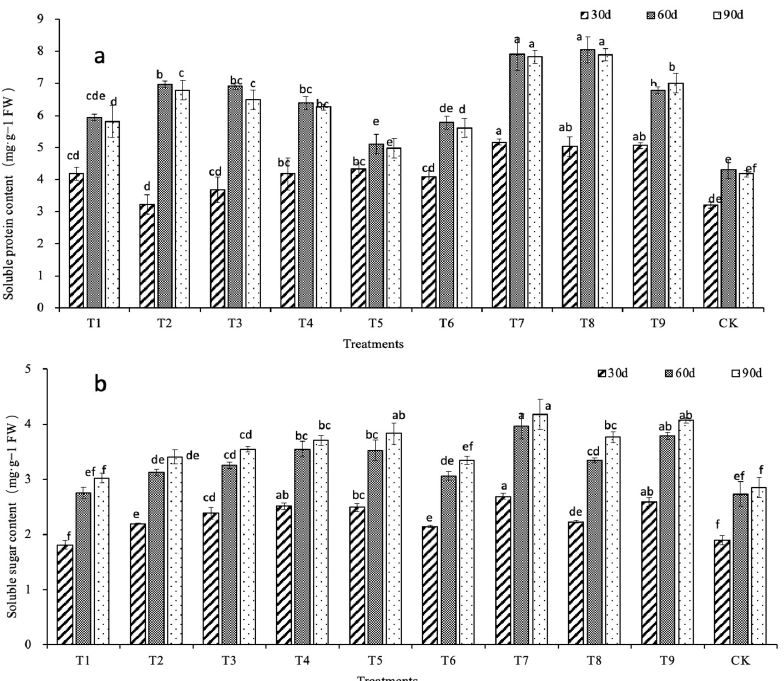
Figure 2. Contents of soluble protein and soluble sugar. ( a ) Soluble protein content. ( b ) Soluble sugar content. Lowercase letters indicate inter group significance ( p < 0.05).